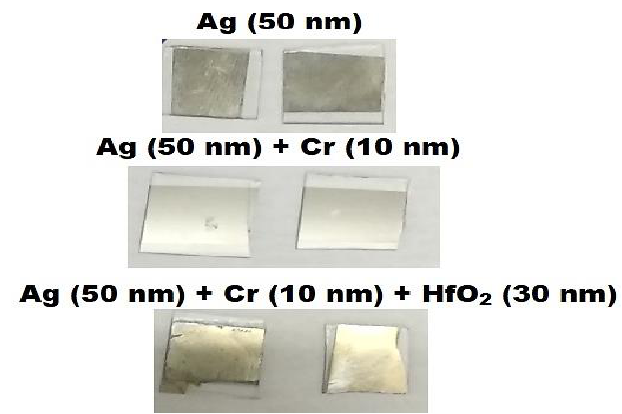
Figure 6. Stepwise coating for Ag, Cr and HfO 2 on Silica glass.